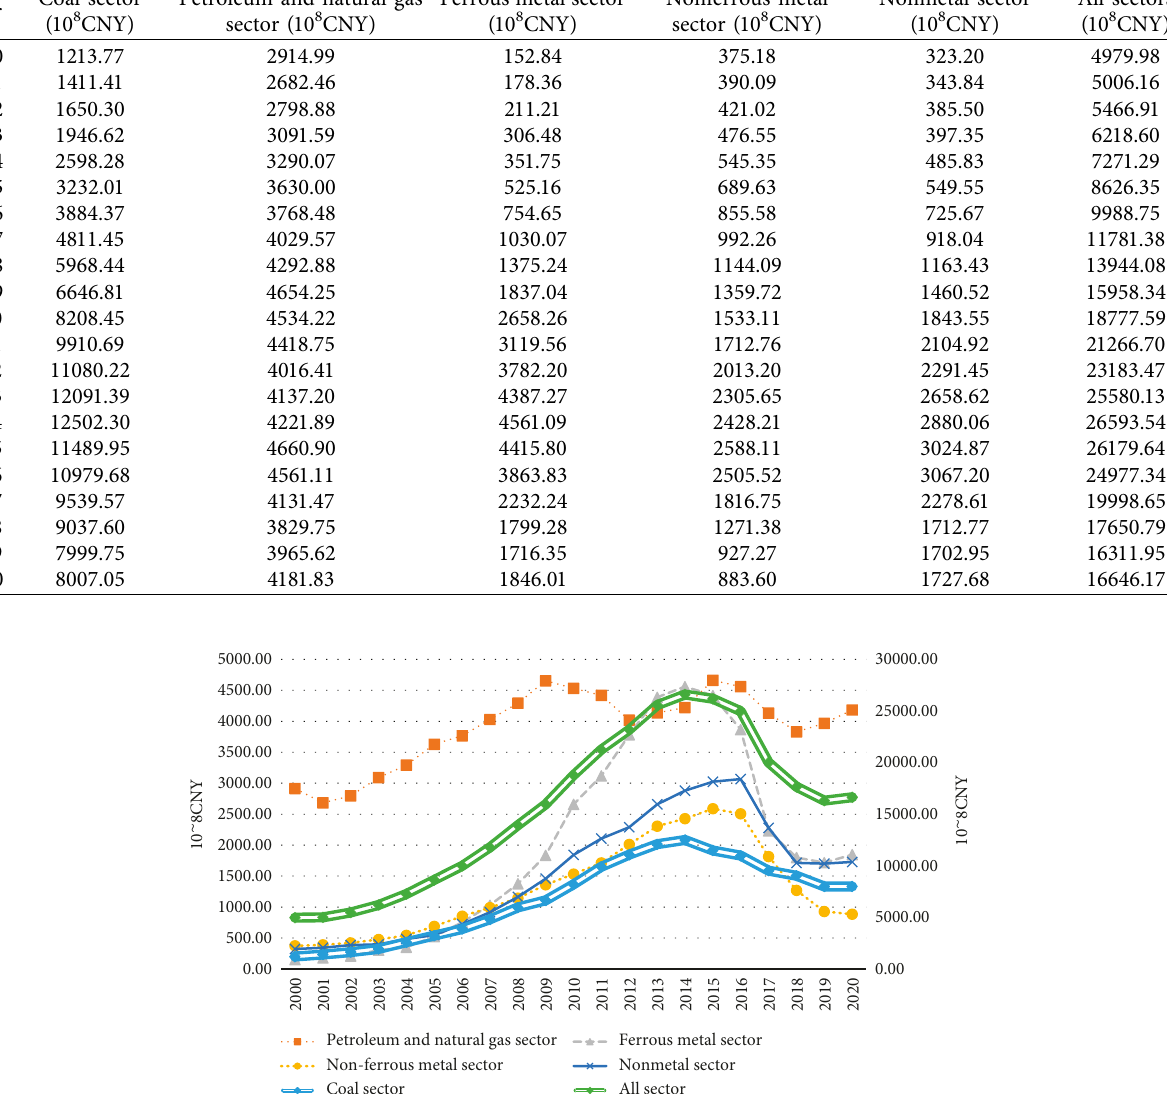
Figure 2: Changes in output value of China’s mining industry and its subsectors from 2000 to 2020. Note. In Figure 2, the values of coal sector and all sectors correspond to the right coordinate axis, and the values of other subsectors correspond to the left coordinate